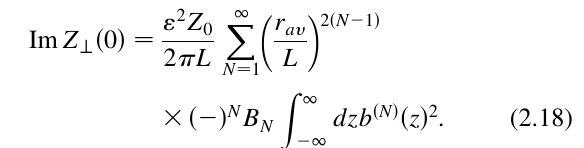
TABLE I. Values of the first eight coefficients B